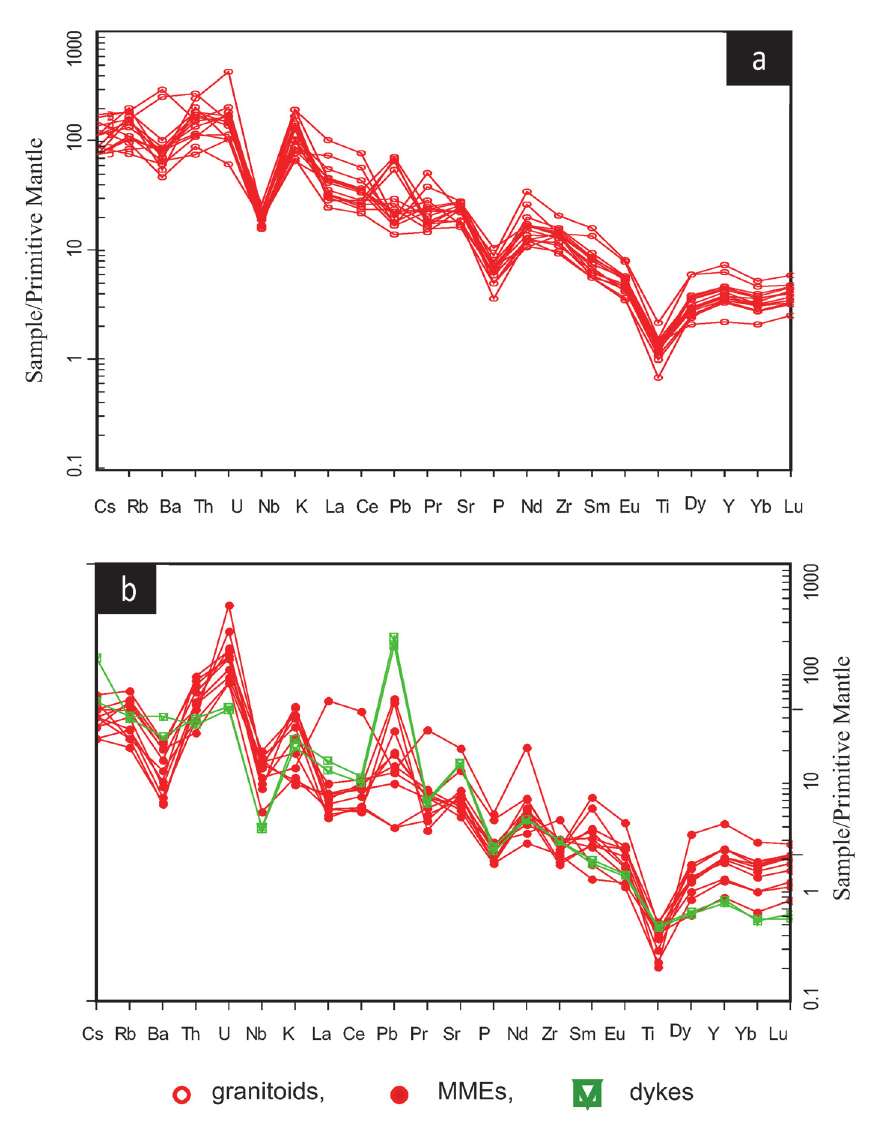
Fig. 6. Primitive mantle normalized spider diagrams of granite samples. Normalizing values are from Sun & McDonough